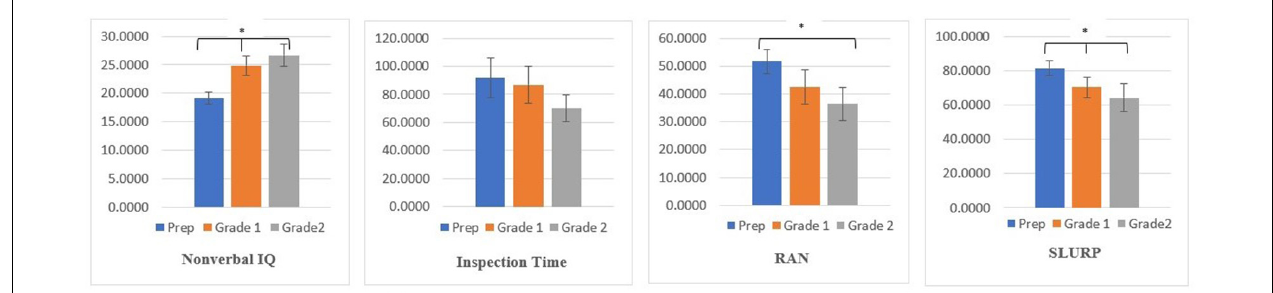
FIGURE 5 | Grades means differences (+/- 95% Confidence Intervals) for, nonverbal IQ, rate of visual information processing (Inspection Time), visual-verbal processing (RNA), and visuomotor processing (SLURP). Note. ∗ p ≤ 0.05.